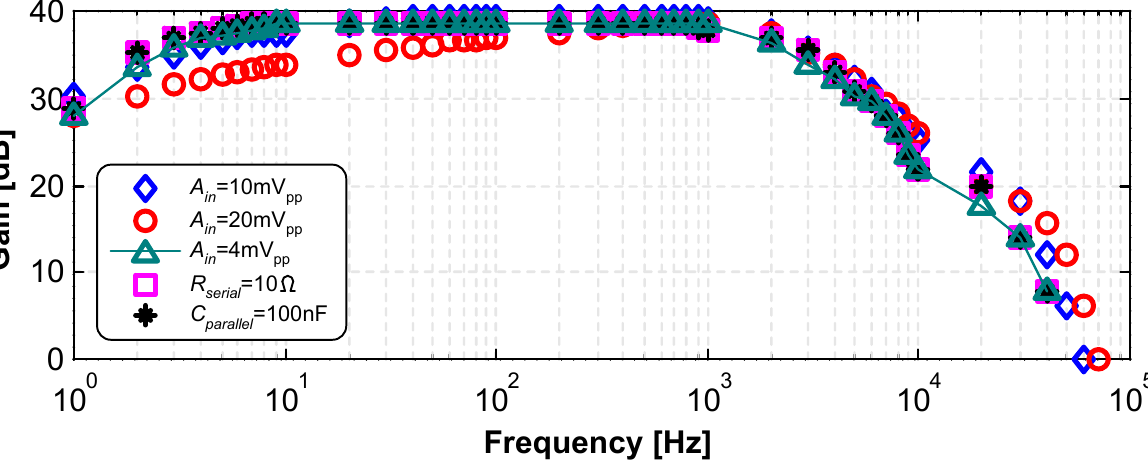
Figure 13. Measured gain for two sets of stress tests: input amplitudes of 10 mVpp and 20 mVpp, and cables from the electrodes with two serial resistance of 10 Ω and with a parallel capacitance of 100 nF.